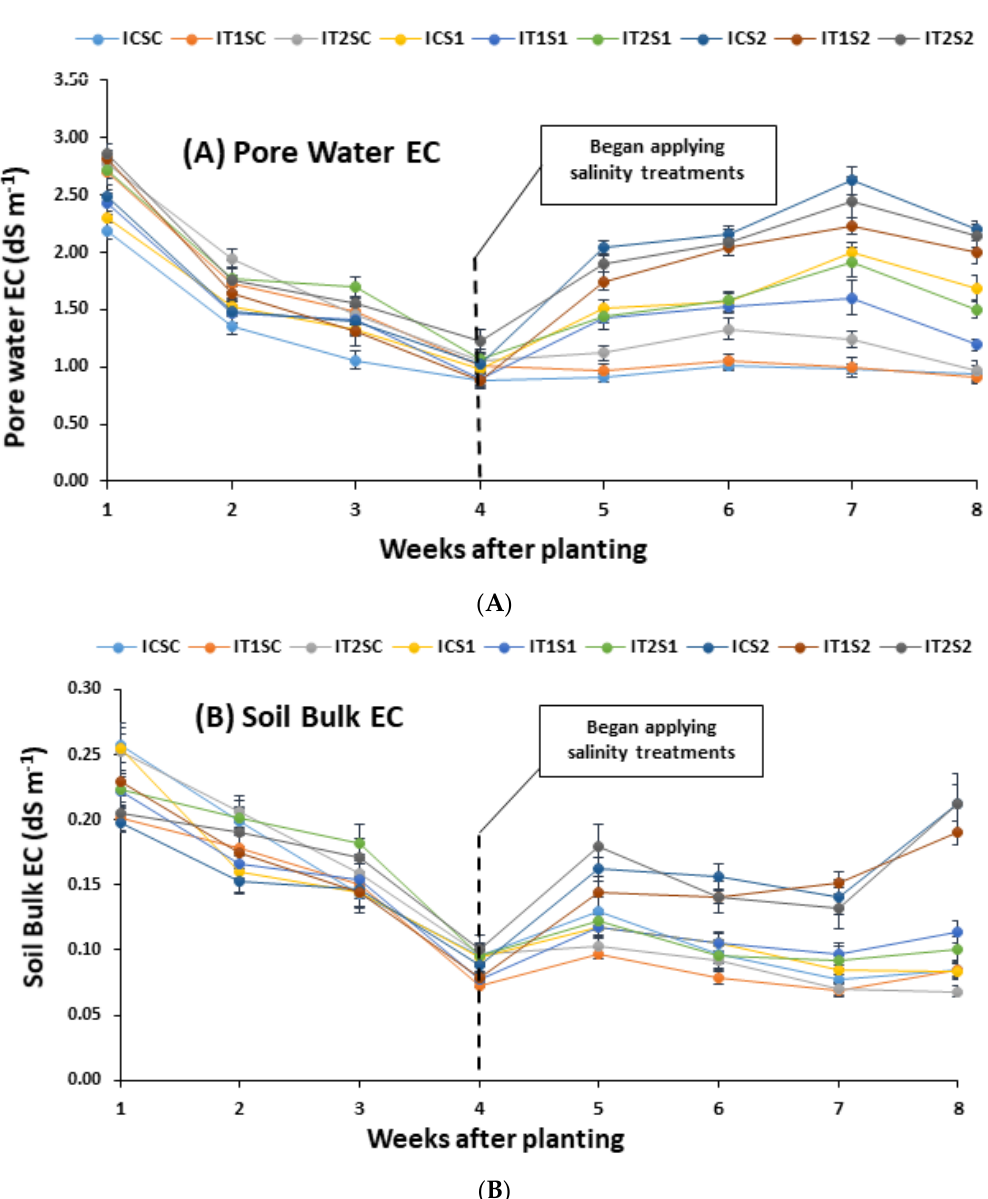
Figure 2. Scatter line graph represents the changes of ( A ) pore water EC and ( B ) soil bulk EC changes over time. Treatments include three different inoculation types (IC = No inoculation, IT1 = AMF, IT2 = Rhizobium + AMF) and three salinity treatments (SC = Salinity control 0.6 dS m −1 EC, S1 = 1.0 dS m −1 EC, and S2 = 2.0 dS m −1 EC). The dashed line represents when snap beans were first irrigated (four weeks after planting) with their corresponding salinity treatment (i.e., 0.6, 1.0, and 2.0 dS m −1 EC). Average values ( n = 10) are presented for each treatment in both graphs. Error bars represents the standard error of mean values.